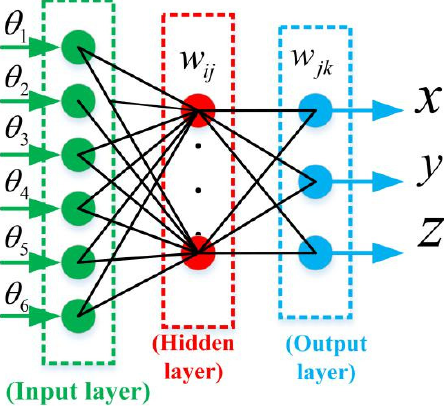
Figure 3. Structure of the back-propagation neural network.